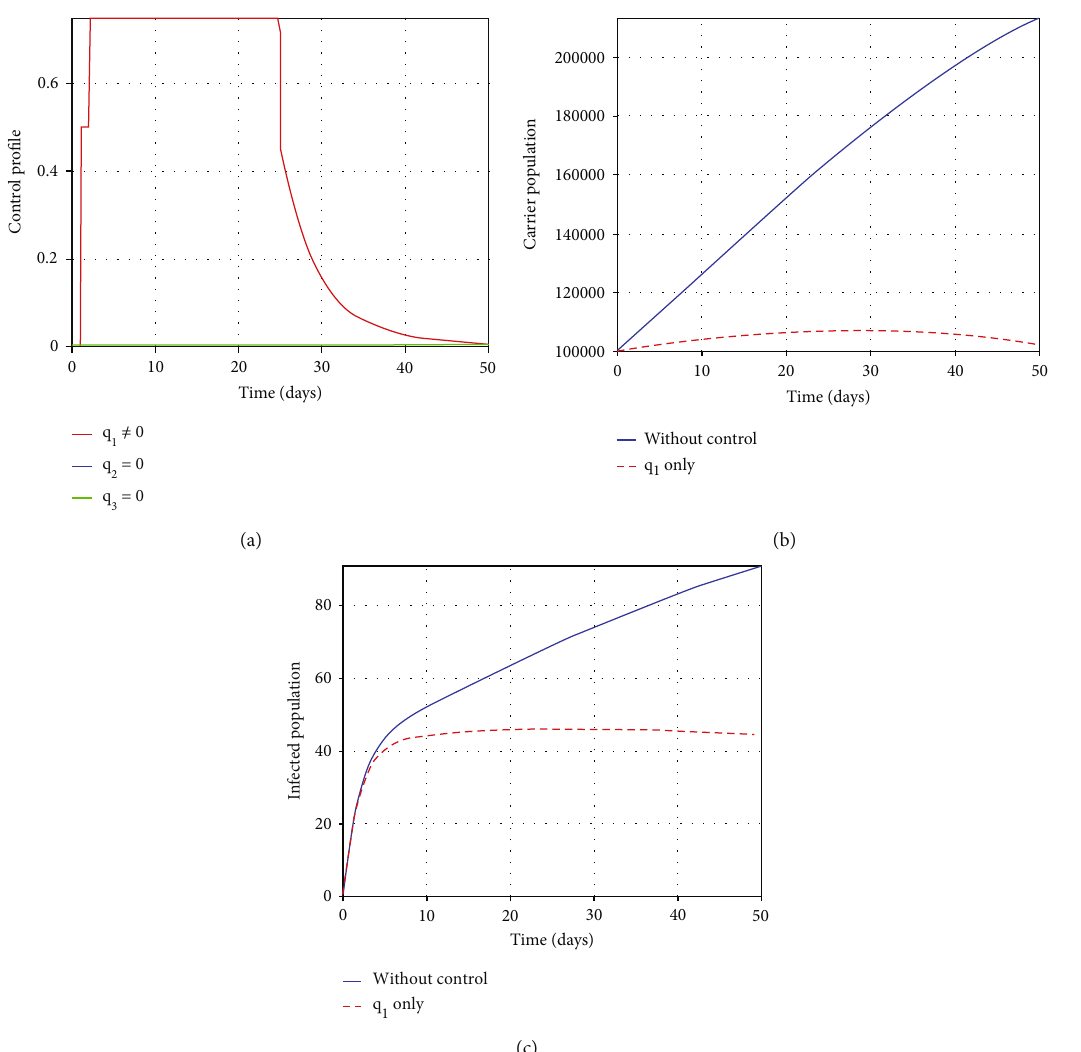
Figure 6: E ff ect of using vaccination only. The control pro fi le associated with the use of vaccination only as an intervention measure in (a) indicates that health practitioners vaccinate about 50% of the population at risk with vaccination within two days and afterward increase the vaccination rate to cater for 80% of the population for 26 days to eradicate meningitis. Changes in the number of carriers in (b) and changes in the infected individuals in (c) show a decrease in these two groups when vaccination is